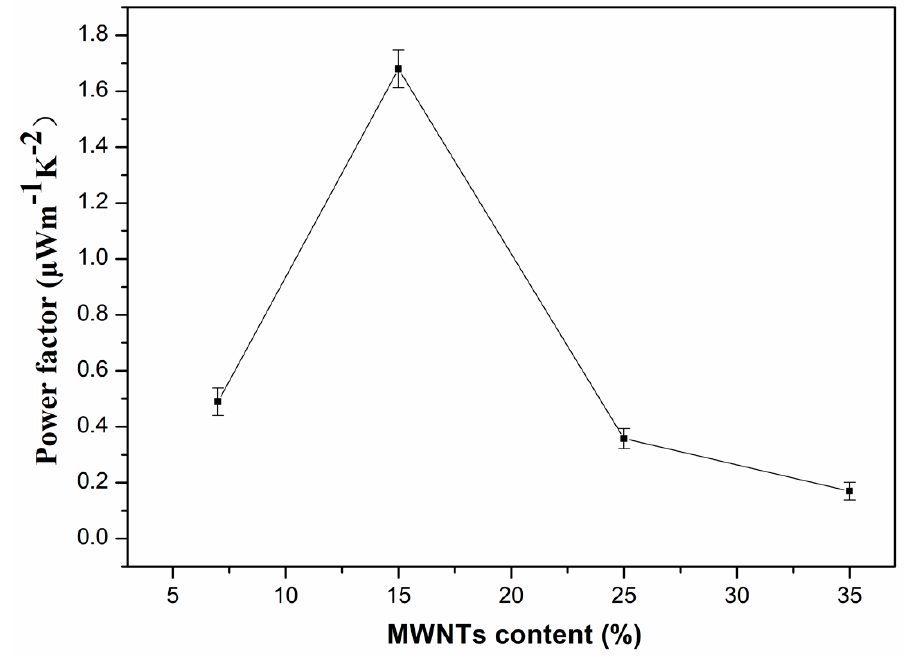
Figure 6. Power factor of PVDF composites with different content of MWNTs at room temperature.